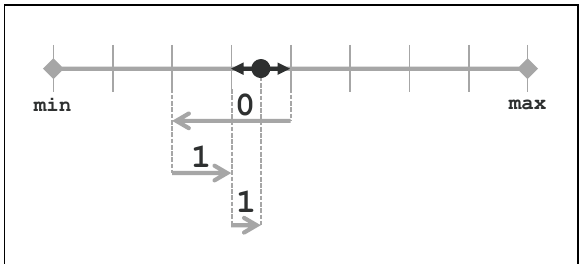
Figure 1. Binary interval